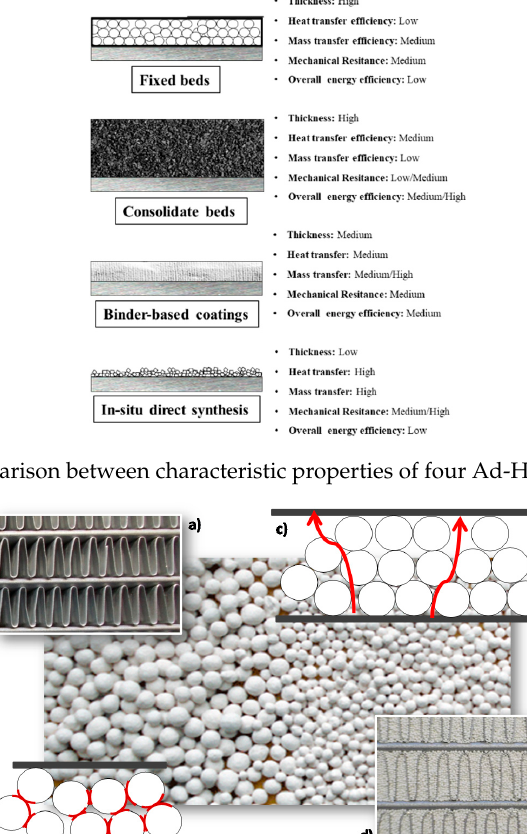
Figure 3. Images of the packed bed Ad-HEX configurations: ( a ) typical finned-tube HEX [18]; ( b ) highlighted heat transfer contact surface inside a fixed bed Ad-HEX; ( c ) typical vapor transfer path inside a fixed bed Ad-HEX; ( d ) fixed bed Ad-HEX based on finned-tube HEX and SAPO-34 adsorbent grains [18]. (Copyright from Elsevier 2015).